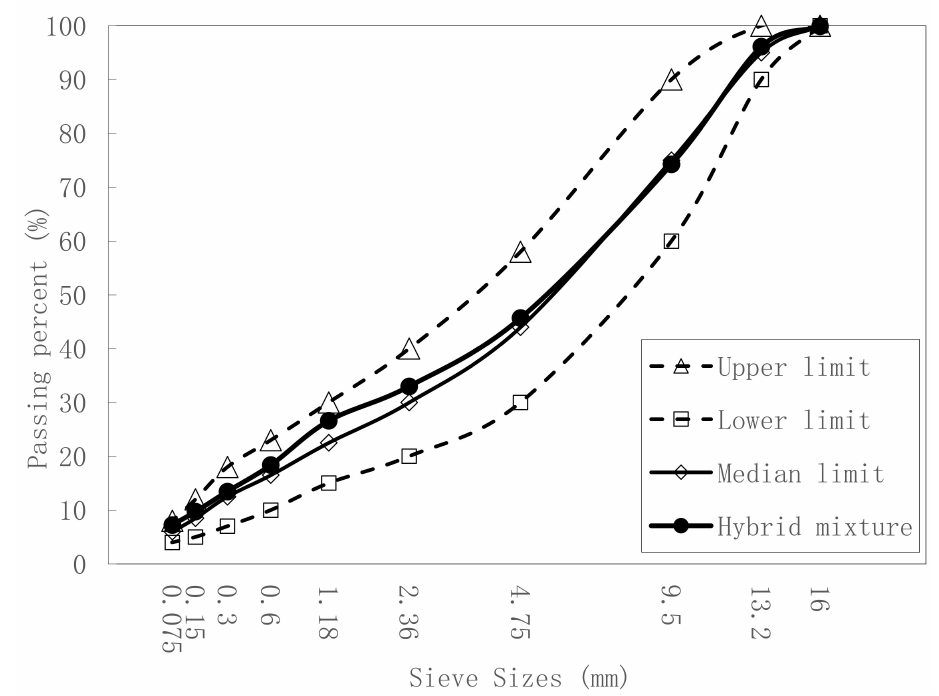
Figure 1. AC-13 gradation